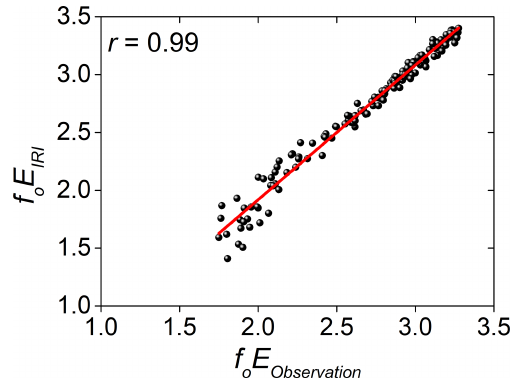
Figure 6. Scatter plot depicting the comparison between fo E IRI ver- sus fo E Observation